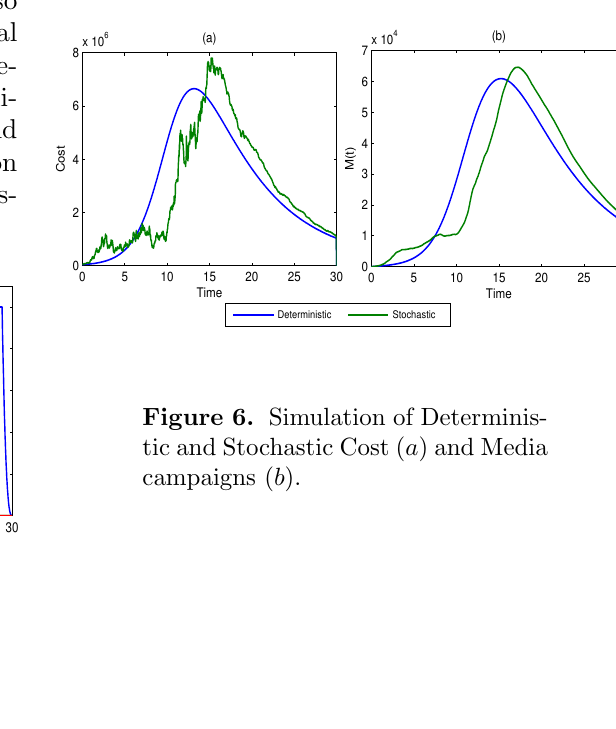
Figure 3. Simulation of Determinis- tic ( a ) and Stochastic ( b ) control pro- file for different values of β 1 .